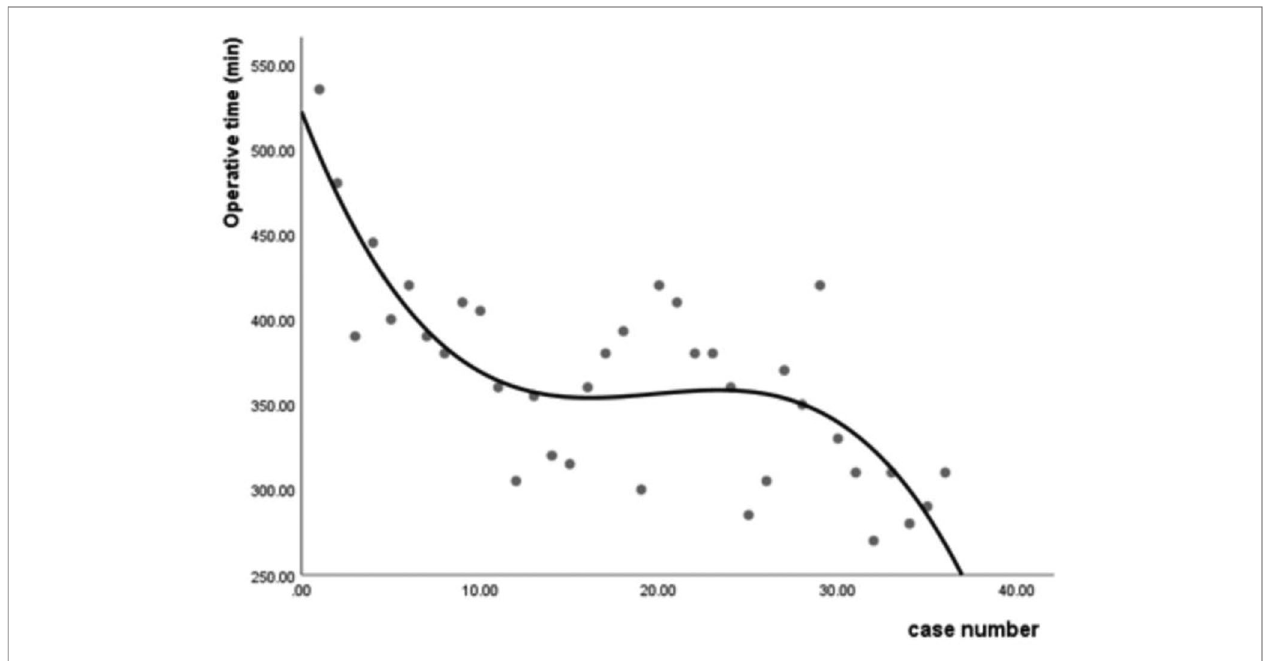
FIGURE 5 | The learning curve of